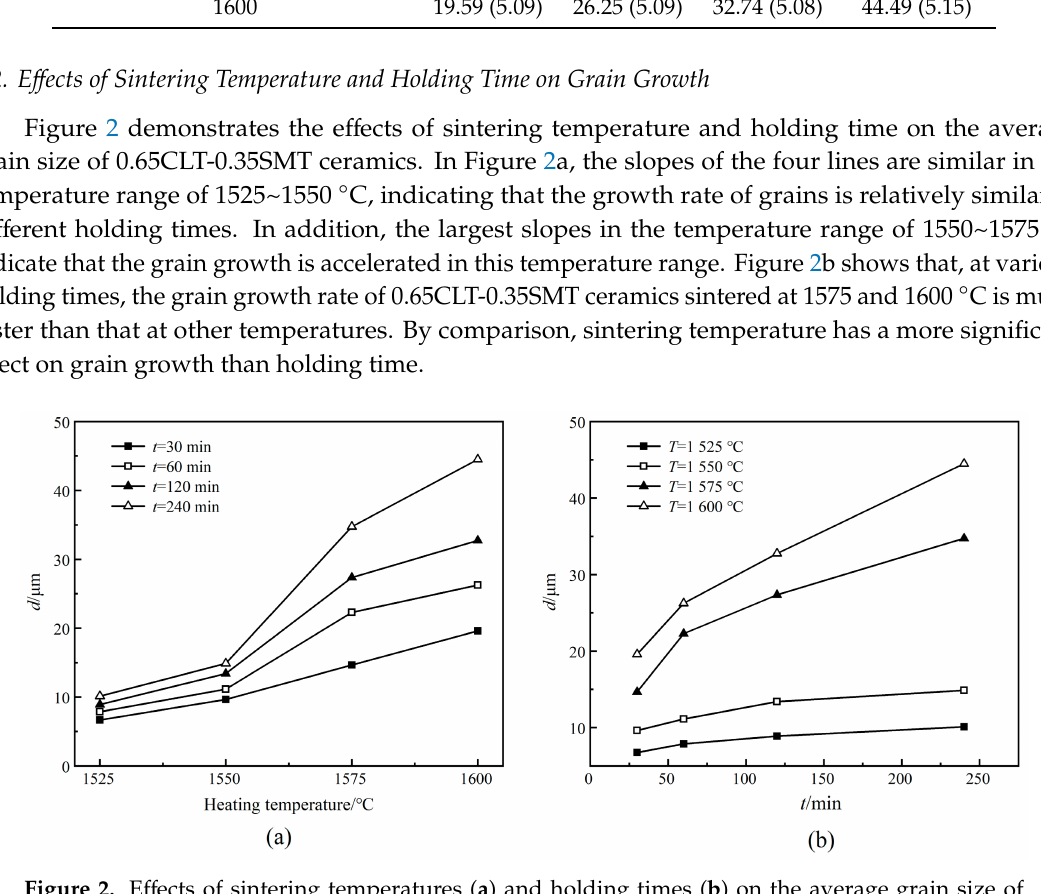
Figure 2. E ff ects of sintering temperatures ( a ) and holding times ( b ) on the average grain size of 0.65CLT-0.35SMT